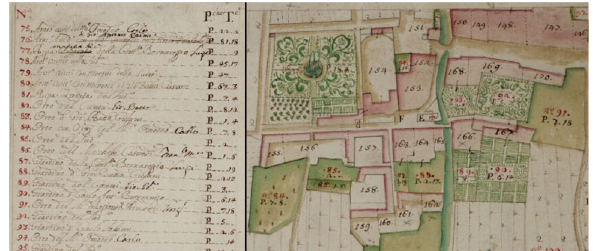
Figure 8. Map Catasto Teresiano (1721) in Cusano. Detailed representation of the purpose of non-built parcels on the right, and on the left land register data. Source: ASMi